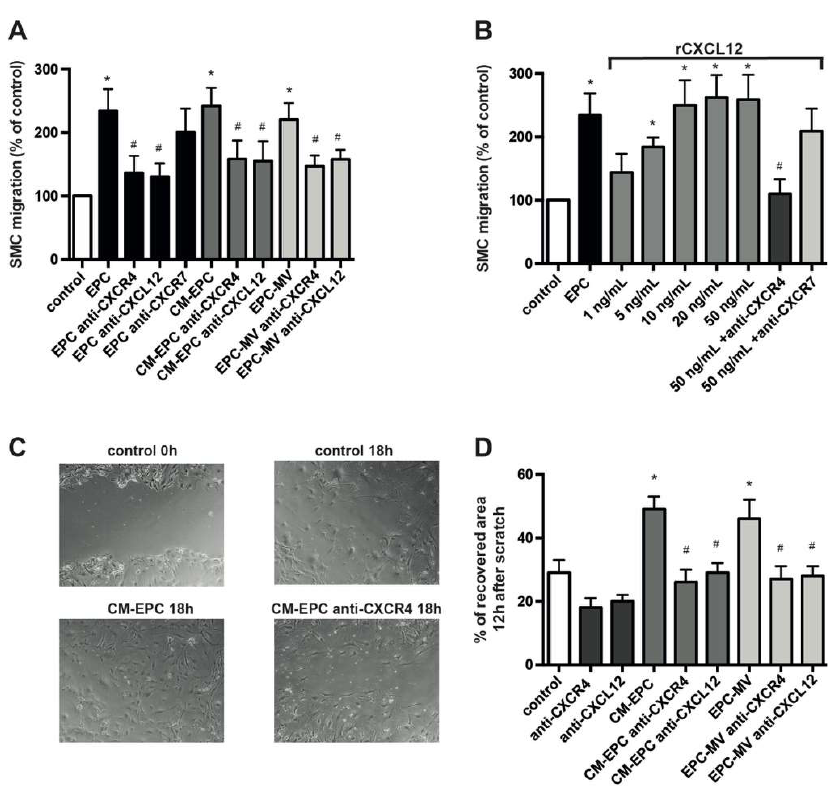
Figure 3. EPCs stimulate migration of SMCs via CXCL12-CXCR4. ( A , B ) Transmigration of SMCs as analyzed in transwell chamber experiments with 8 μm pores and expressed as percentage of control. The bottom chamber contained migration medium (DMEM plus 0.5% FBS) supplemented with various doses of rCXCL12, EPCs or their secretory products in the absence or presence of blocking Abs as indicated. * p < 0.05 vs. control, # p < 0.05 vs. respective treatment in the absence of blocking Abs; n = 6. ( C , D ) SMC scratch assay. Subconfluent monolayers of SMCs, treated as indicated, were wounded linearly, and the area of the wound subsequently recovered by migrated SMCs was expressed as a percentage of the initial wound area. Representative photomicrographs ( C ) and quantified data ( D ) are shown. * p < 0.05 vs. untreated SMCs (control), # p < 0.05 vs. respective treatment in the absence of blocking Abs; n =